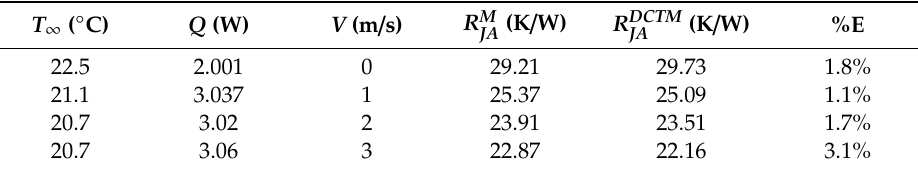
Table 5. Approximation of 2s2p thermal metrics (Icepak ® ).